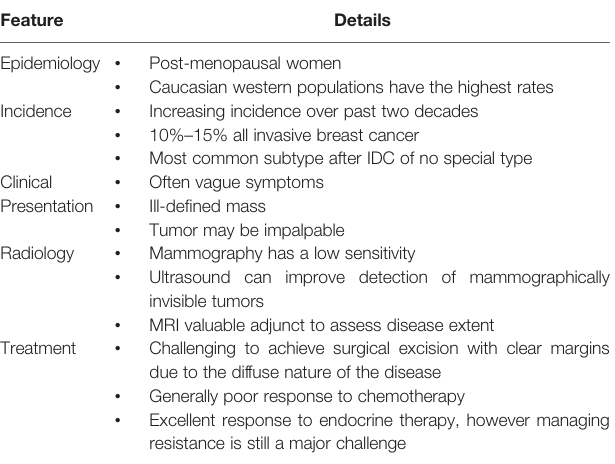
TABLE 2 | Summary of Key Characteristics of